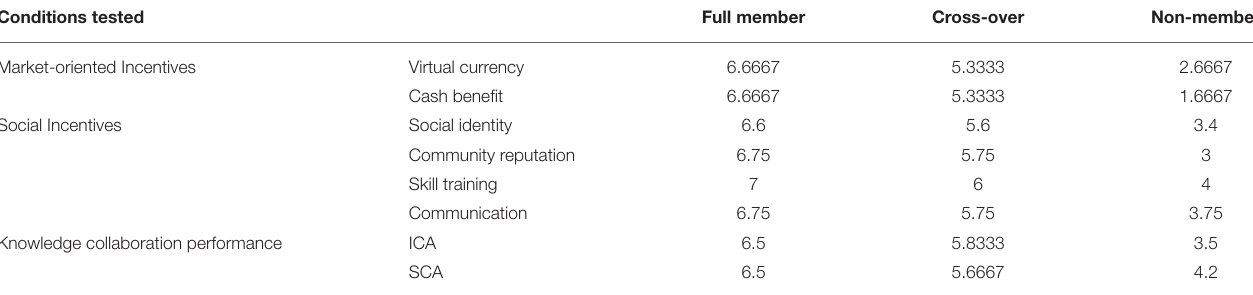
TABLE 2 | The calibration criteria for the variables. Conditions